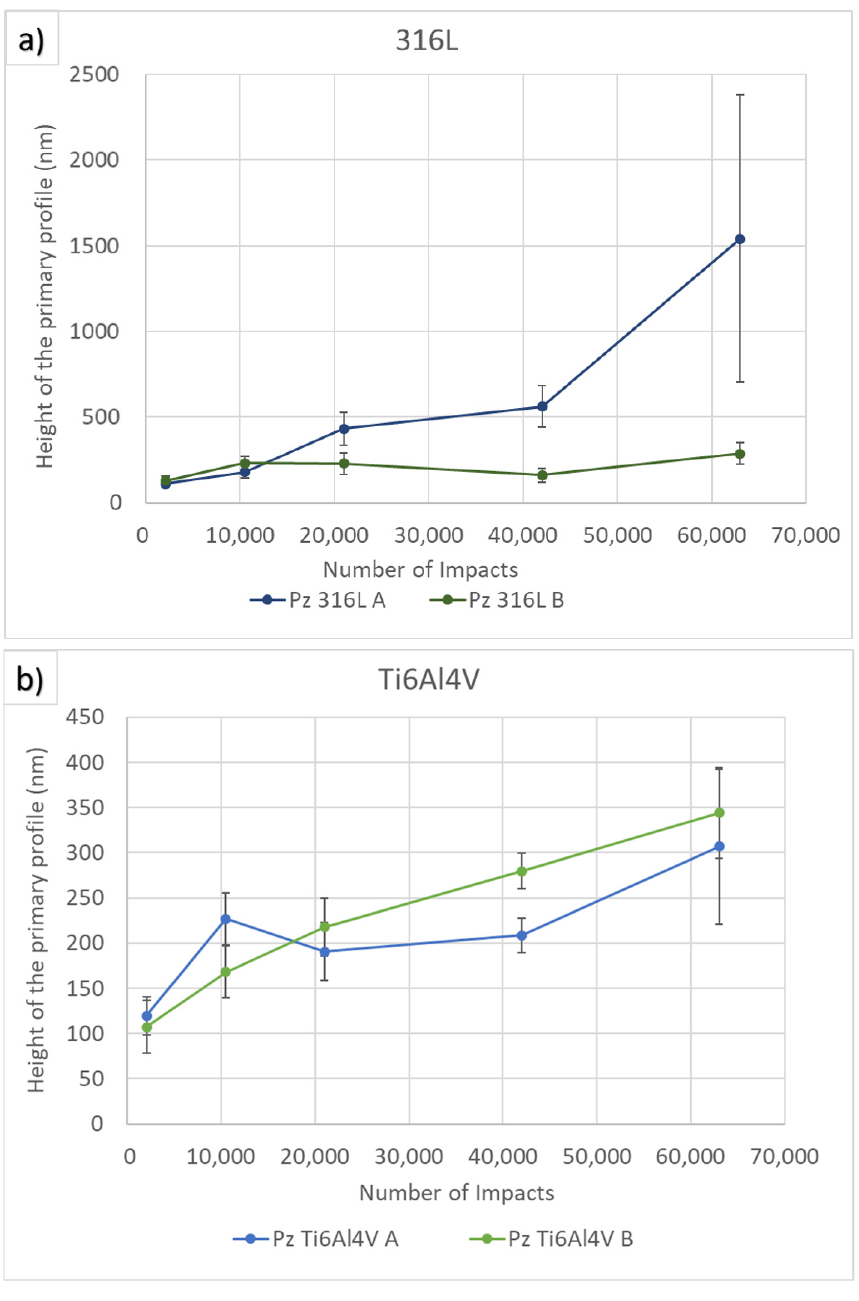
Figure 7. The relationship of primary profile parameter Pz with number of impacts. ( a ) shows evolution in austenitic stainless steel 316L and ( b ) shows evolution in two phase titanium alloy Ti6Al4V.